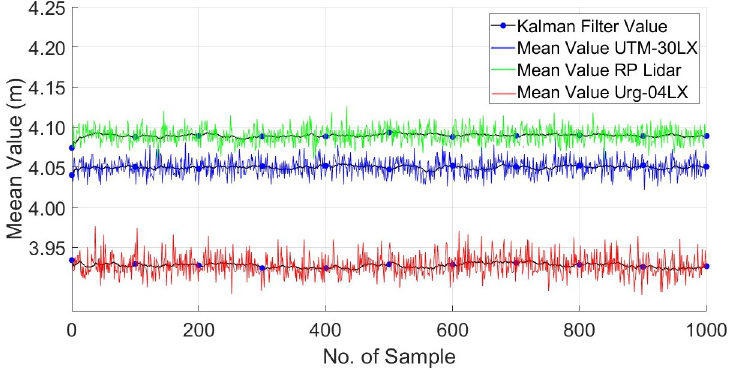
Fig 24. Plot of mean range measurements estimated through